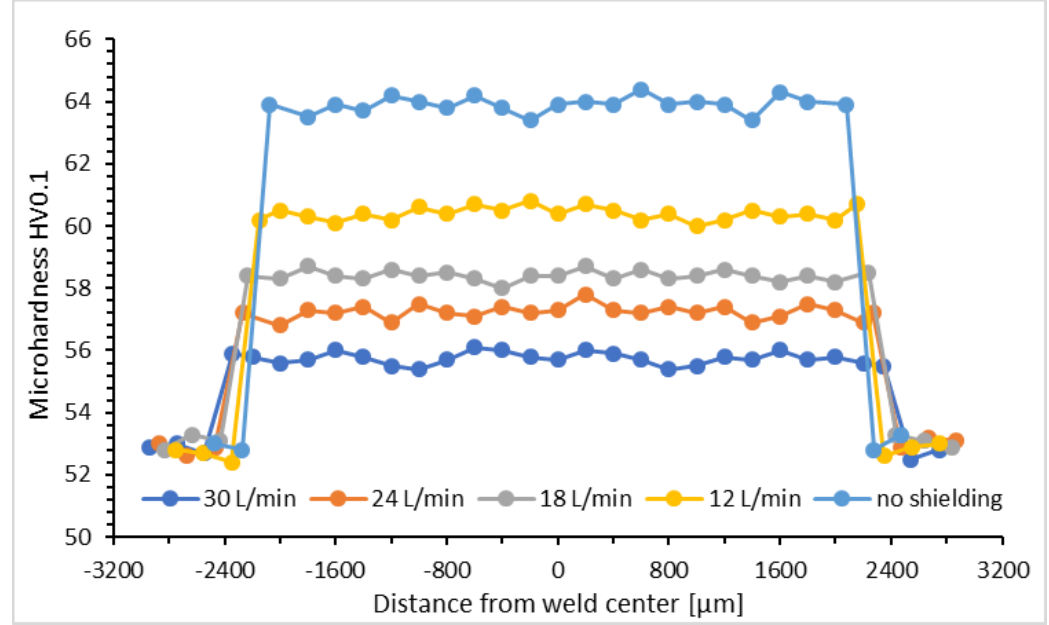
Figure 14. Microhardness course of welds created under various gas flow rates.